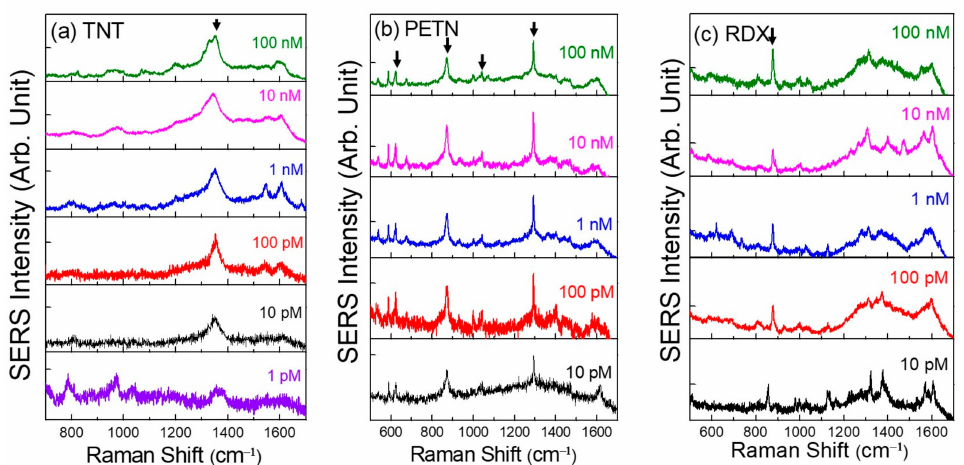
Figure 4. The SERS spectra of explosive materials at various mole concentrations. ( a ) SERS spectra of TNT with different concentrations. SERS spectra of ( b ) PETN and ( c ) RDX.